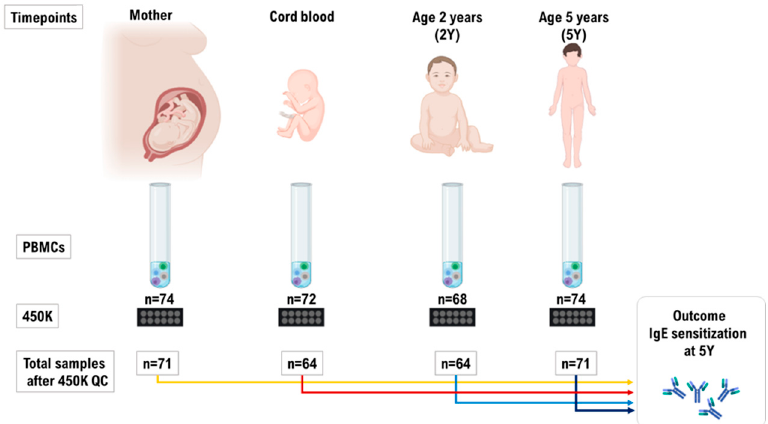
Figure 1. A schematic representation of the study time points, samples, and outcome. Detailed information on quality control and the excluded samples is presented in Figure S1.